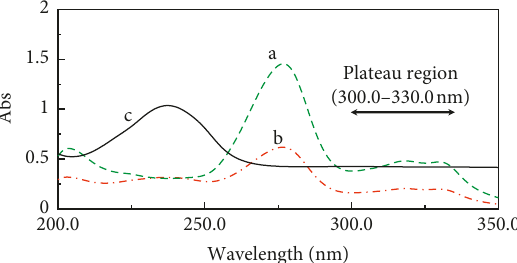
Figure 5: (a) Zero-order absorption spectrum of (CIP) ′ (12.0 μ g/mL) as a divisor; (b) zero-order absorption spectrum of a mixture of (CIP) and FLU (5.0 μ g/ml each); (c) ratio spectrum of this mixture using of (CIP) ′ (12.0 μ g/mL) as a divisor showing in the plateau region (300.0–330.0 nm).